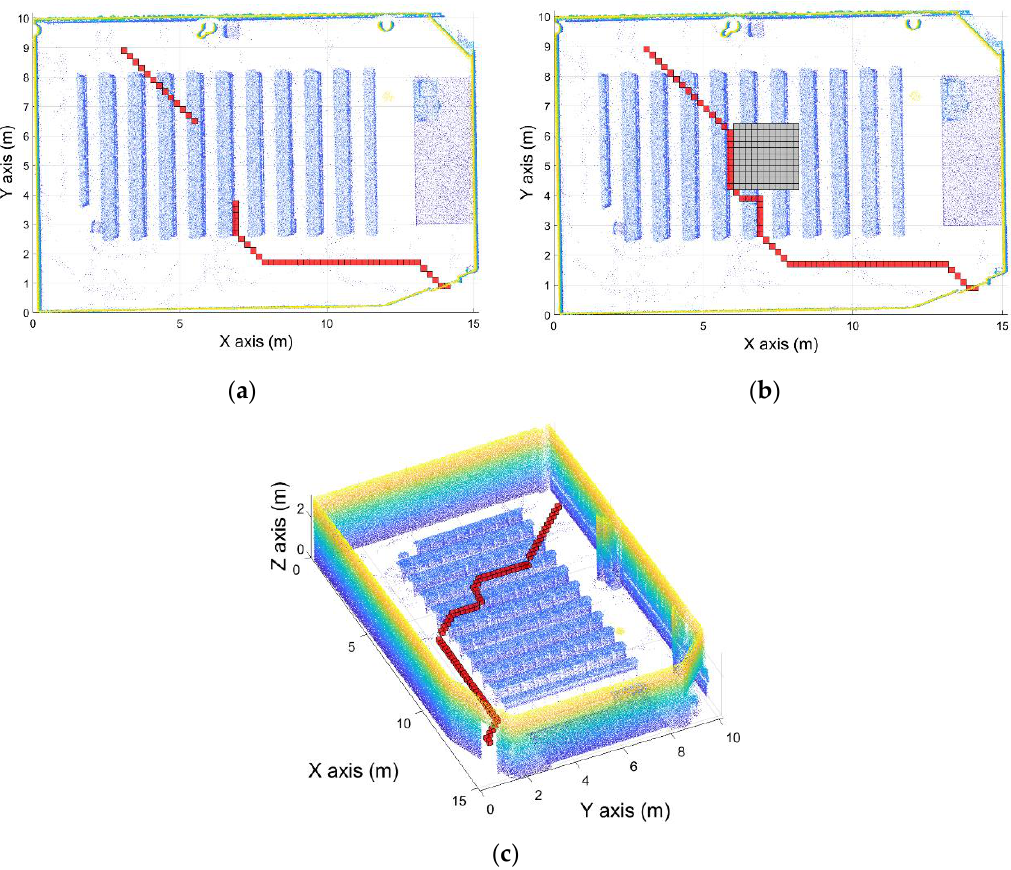
Figure 18. Obstacle avoidance path planner. ( a ) Path segmented before and after the obstacle. ( b ) New path calculated avoiding the obstacle with a security offset. ( c ) Path calculated.